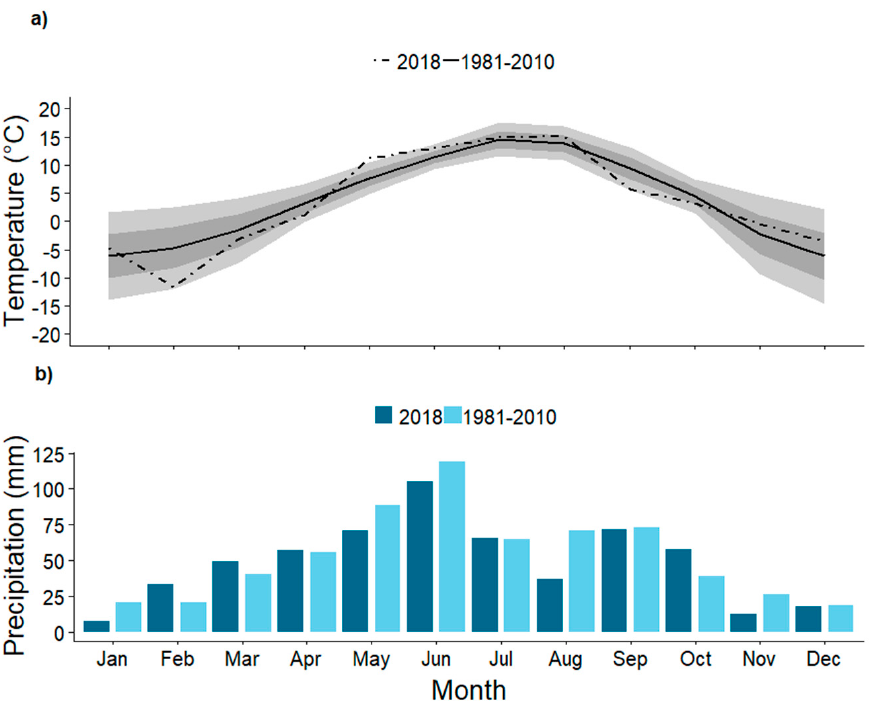
Figure 2. Images of the seasonal evolution of our research site during ( a ) Snow Melt, ( b ) Green-Up, ( c ) Peak Growing Season and ( d ) Late Growing Season. Images were taken during the 2018 field campaign on ( a ) 18 June, ( b ) 6 July, ( c ) 26 July and ( d ) 28 September.